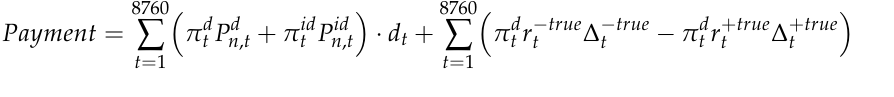
Table 3. Normalized mean squared errors of random variables.